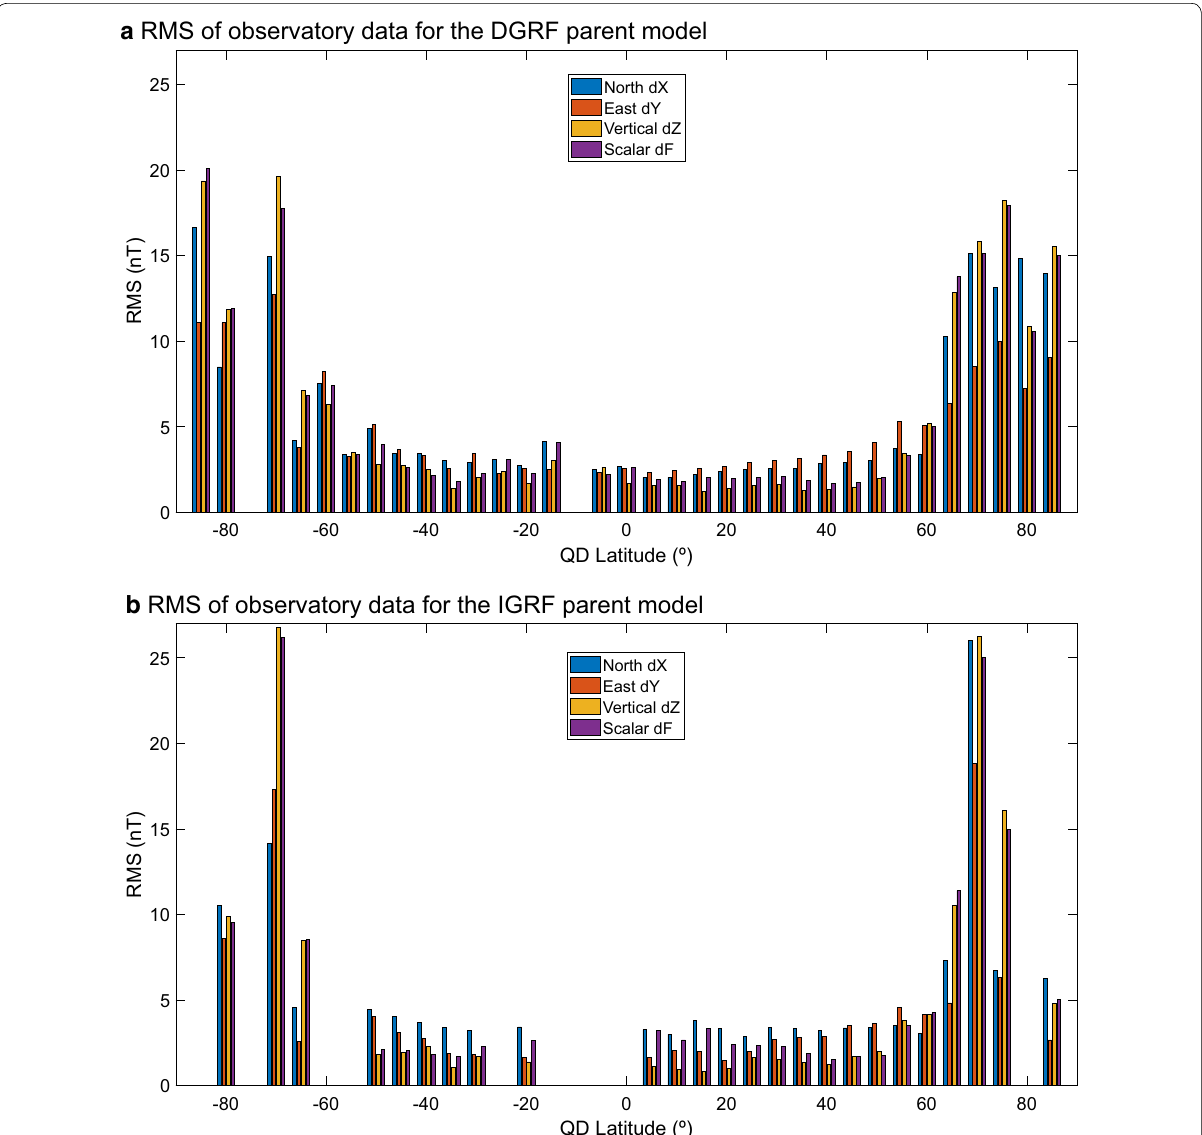
Fig. 7 RMS errors for each vector and scalar elements for the observatory data used in the a DGRF and b IGRF parent